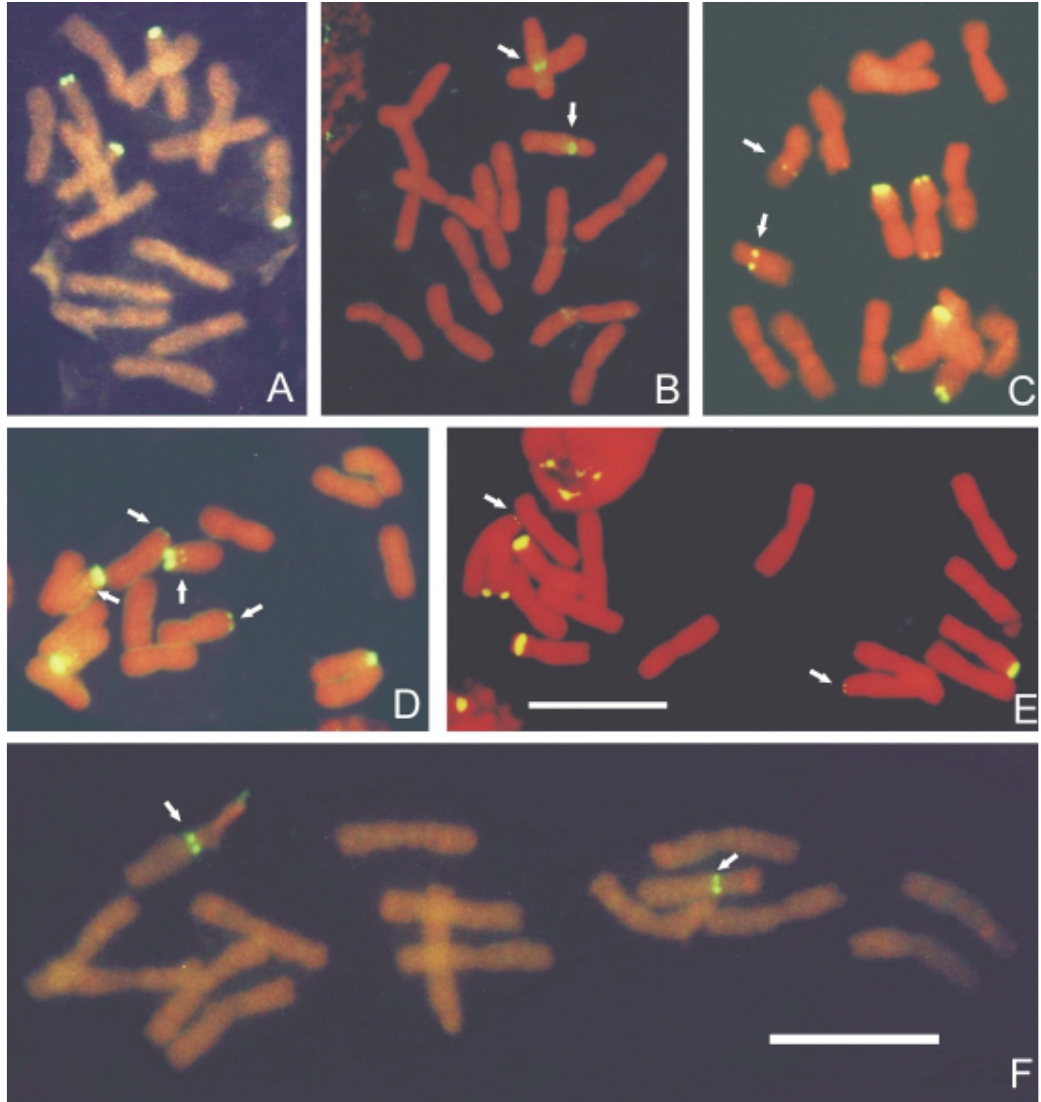
Figure4 -Fluorescent insitu hybridization(FISH)withthep Ta 71(45SrDNA)andp Ta 794(5SrDNA)clonesin Cestrum species.(A)Metaphasehybrid- ized with 45S rDNA probe in C. amictum . (B) Metaphase hybridized with 5S rDNA probe in C. amictum , arrows indicate out proximal signals. (C) Metaphaseof C.sendtnerianum hybridizedatthesametimewith45Sand5SrDNAprobes,arrowsindicateterminalandtenuous45SrDNAsignals(note a chromosome with two hybridization signals) and proximal 5S rDNA hybridization signals. (D) Metaphase of C. intermedium hybridized at the same timewith45Sand5SrDNAprobes,arrowsindicateterminalandtenuous45SrDNAsignalsandproximal5SrDNAhybridizationsignals.(E)Metaphase of C. strigilatum hybridized with 45S rDNA probe, arrows indicate a terminal and tenuous hybridization signal. (F) Metaphase of C. strigilatum hybrid- ized with 5S rDNA probe, arrows indicate proximal hybridization